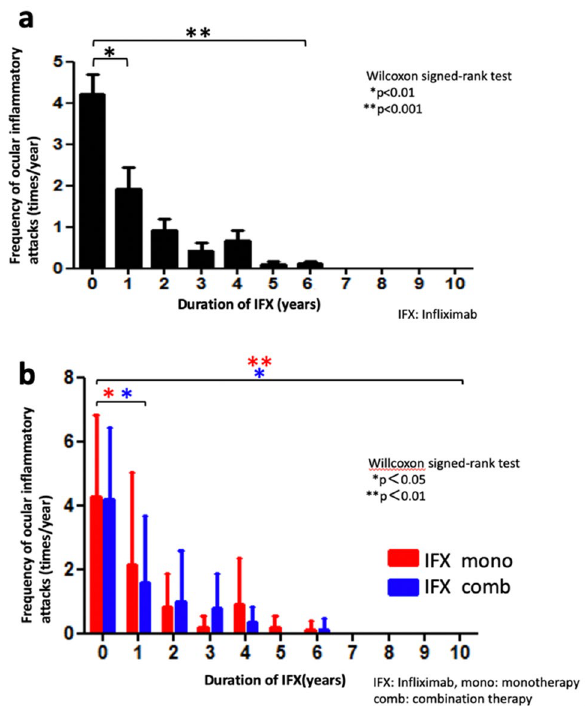
Figure 2. Frequency of inflammatory attacks. ( a ) The overall mean frequency of inflammatory attacks was 4.2 times/year before IFX therapy. Inflammatory attacks significantly decreased to 1.9 times/year at 1 year (p = 0.0030). A slight increase in the attacks (0.7 times/year) was seen at 4 years. Inflammatory attacks were not seen after 7 years of IFX treatment. ( b ) A comparison of the frequency of inflammatory attacks for the